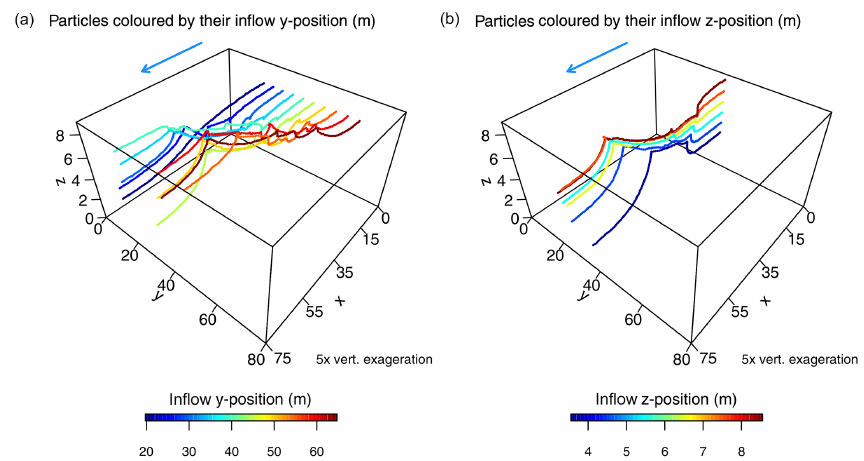
Figure 11. Selected particles coloured by their (a) y coordinate position and (b) z coordinate position on the inflow face. The blue arrow indicates the main flow